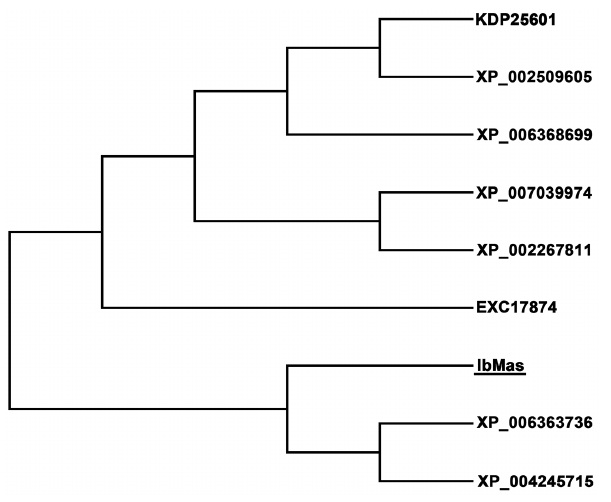
Fig. 2. Phylogenetic tree of IbMas protein with its homologous proteins. The branch lengths are proportional to distance.